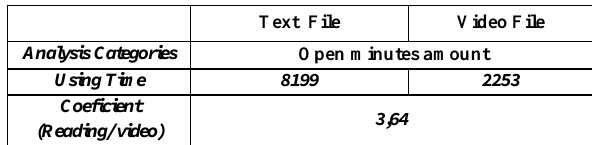
Table 4. Analysis file type/open minutes